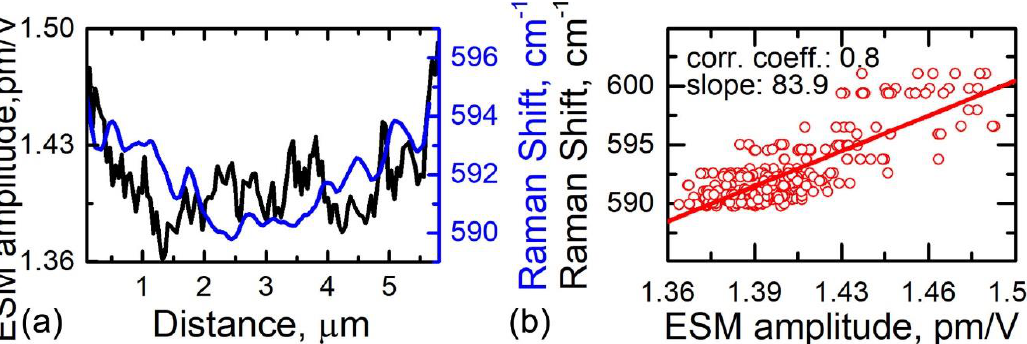
Figure 5. Correlation analysis of confocal Raman microscopy and ESM data. ( a ) Overlapped image profiles along the corresponding lines indicated in Figures 1c (Raman shift) and 2b (ESM amplitude). ( b ) Circles: experimental A 1 Raman peak shift versus ESM amplitude for a number of line profiles similar to those shown in ( a ); solid line: linear fit for the experimental data points.